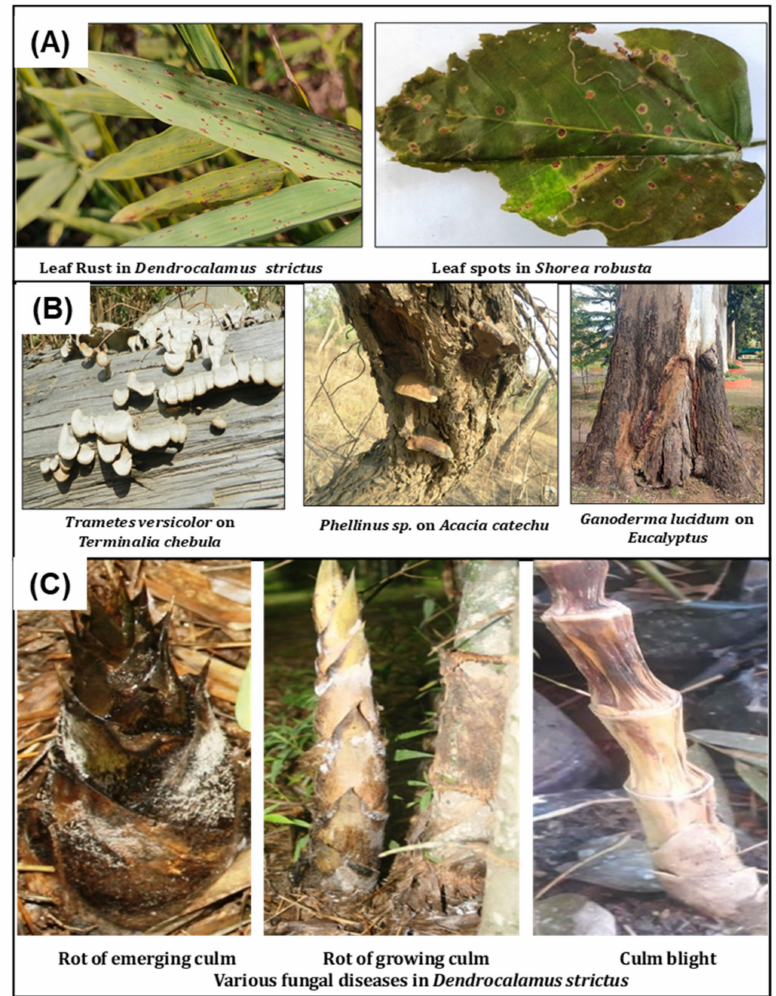
Figure 2. Different Foliar disease: ( A ), stem disease, ( B ) culm disease in bamboo, and ( C ) in forest tree